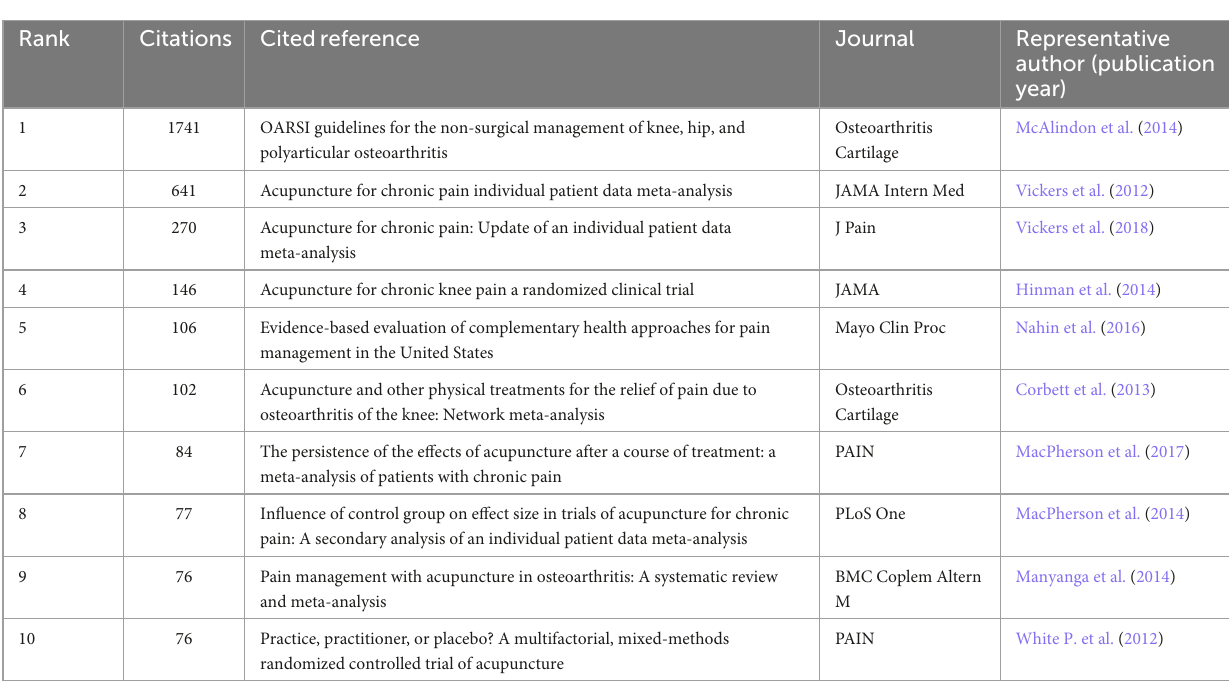
TABLE 7 Top 10 cited references related to Chinese non-pharmacological therapy on